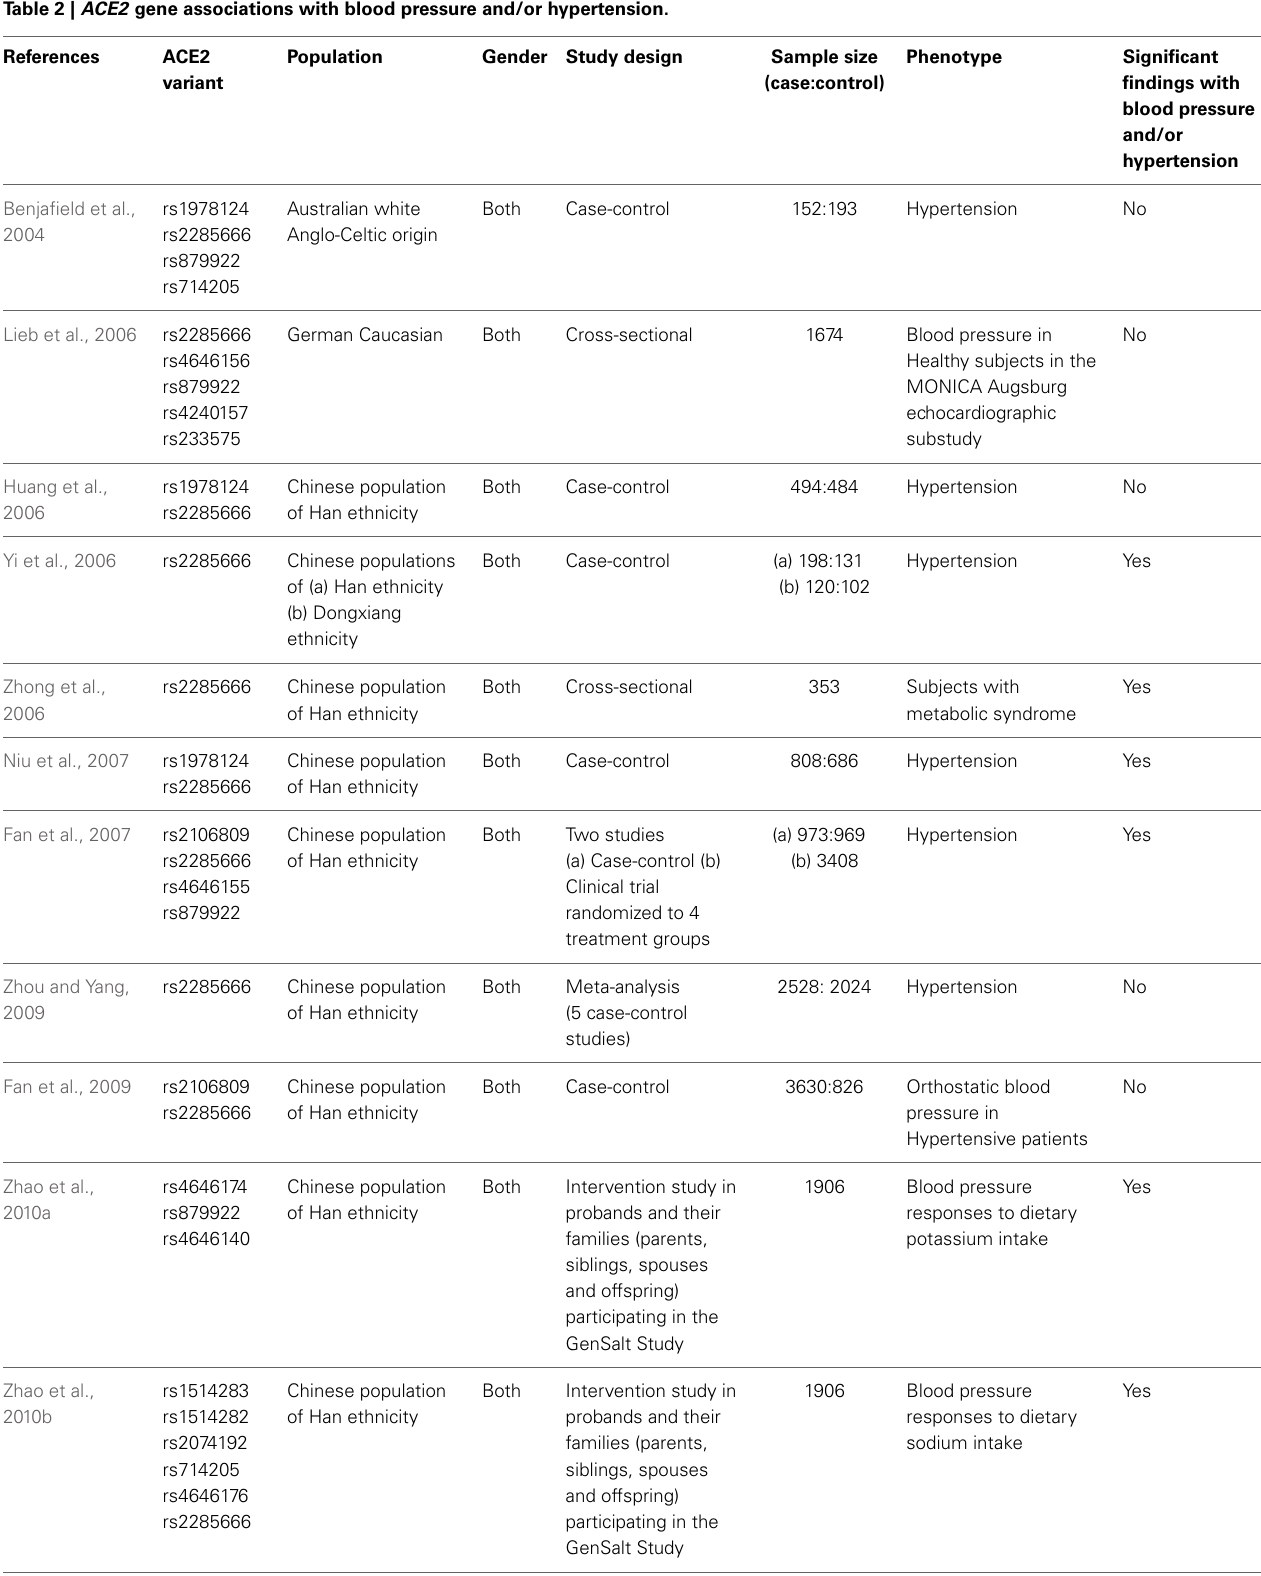
Table 2 | ACE2 gene associations with blood pressure and/or